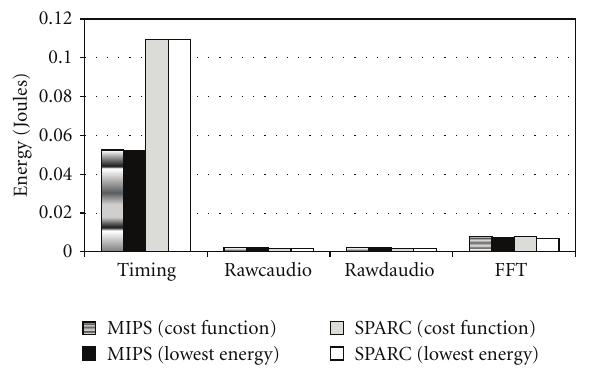
Figure 9: Energy estimation for di ff erent applications.